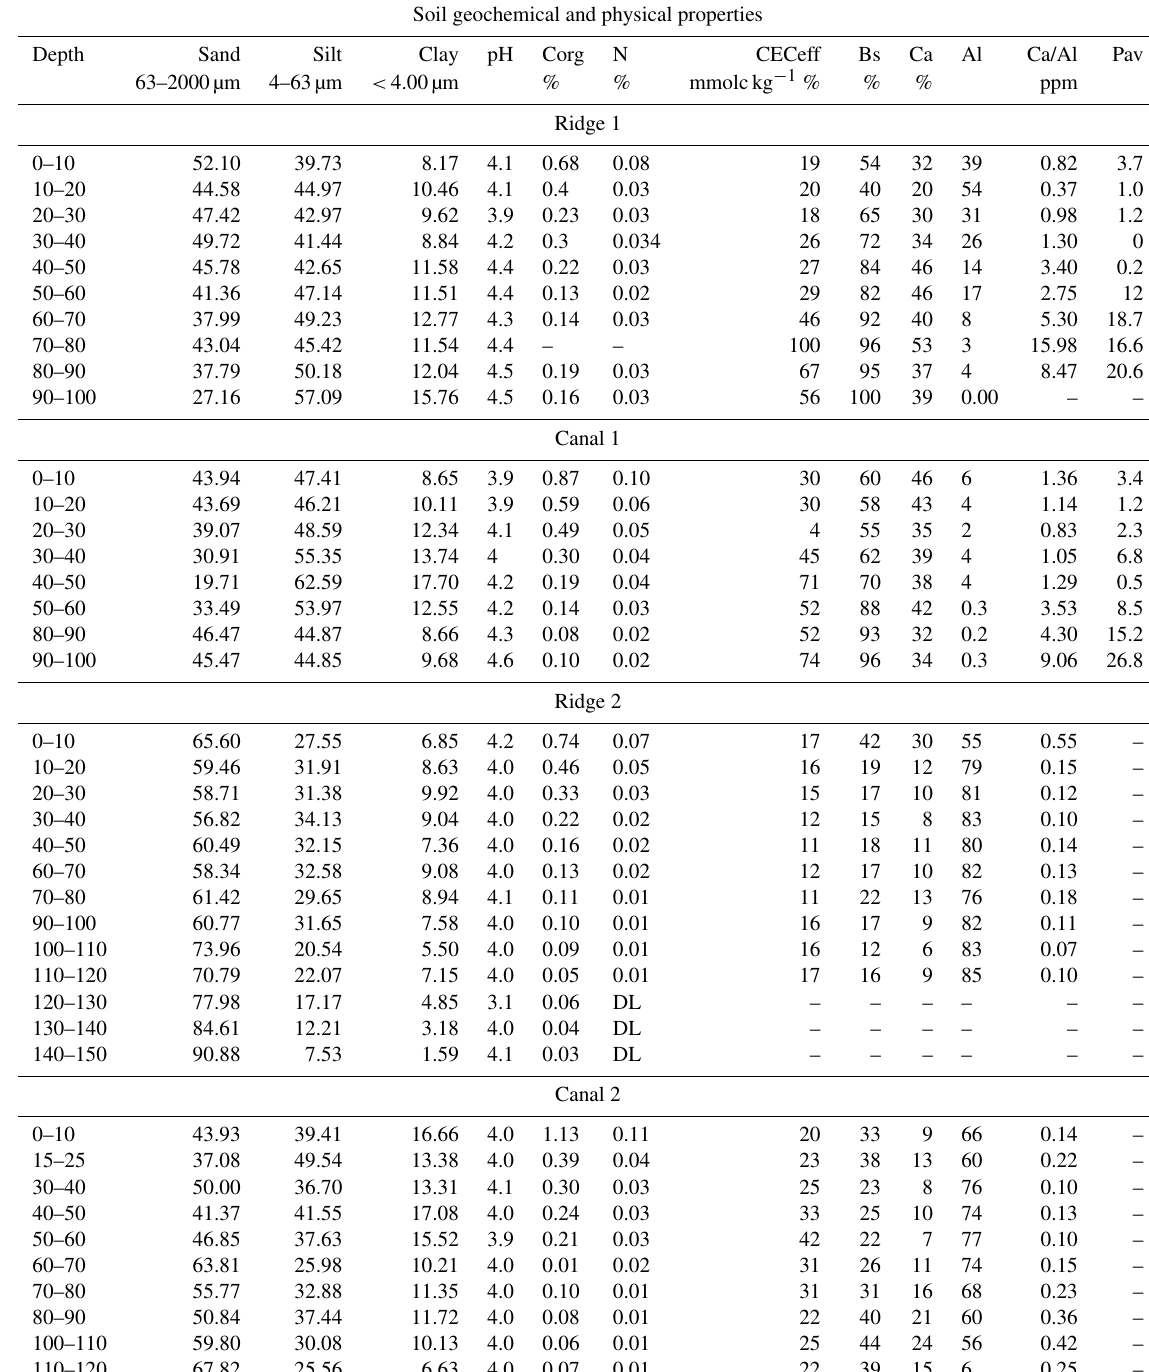
Table 1. Down-profile values of selected geochemical parameters and grain size of all Fields (ridges and canals).